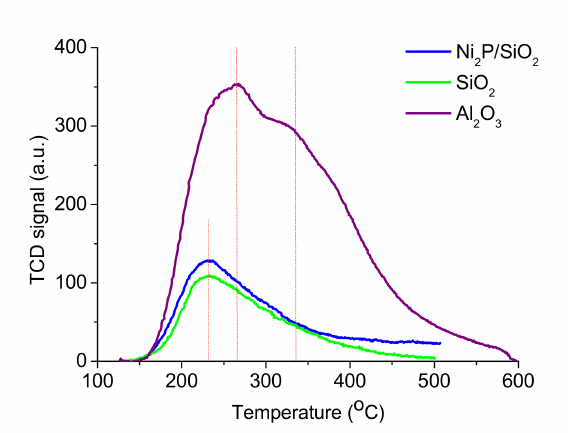
Figure 3. Temperature-programmed desorption of ammonia (NH 3 -TPD) profiles of Ni 2 P/SiO 2 catalyst, silica (SiO 2 ), and acidic support ( γ -Al 2 O 3 )